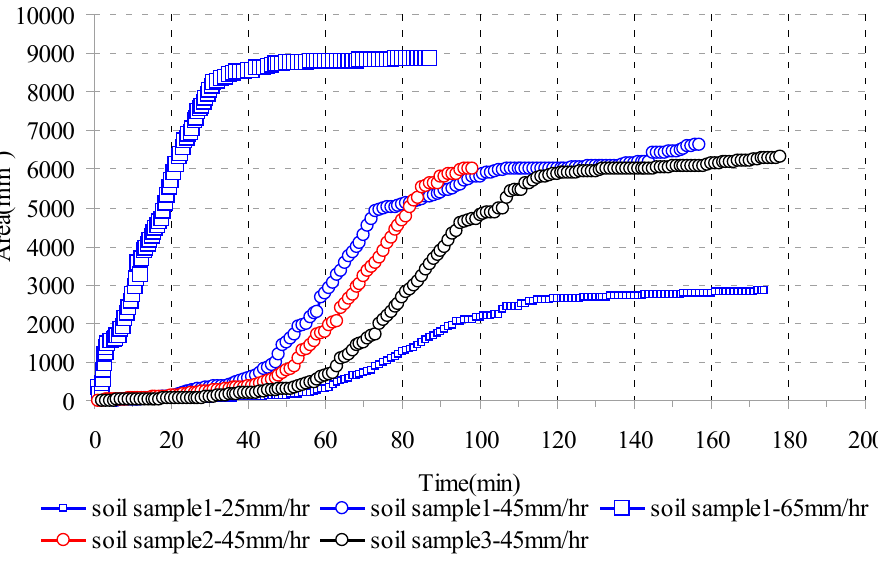
Figure 6. Results of soil erosion